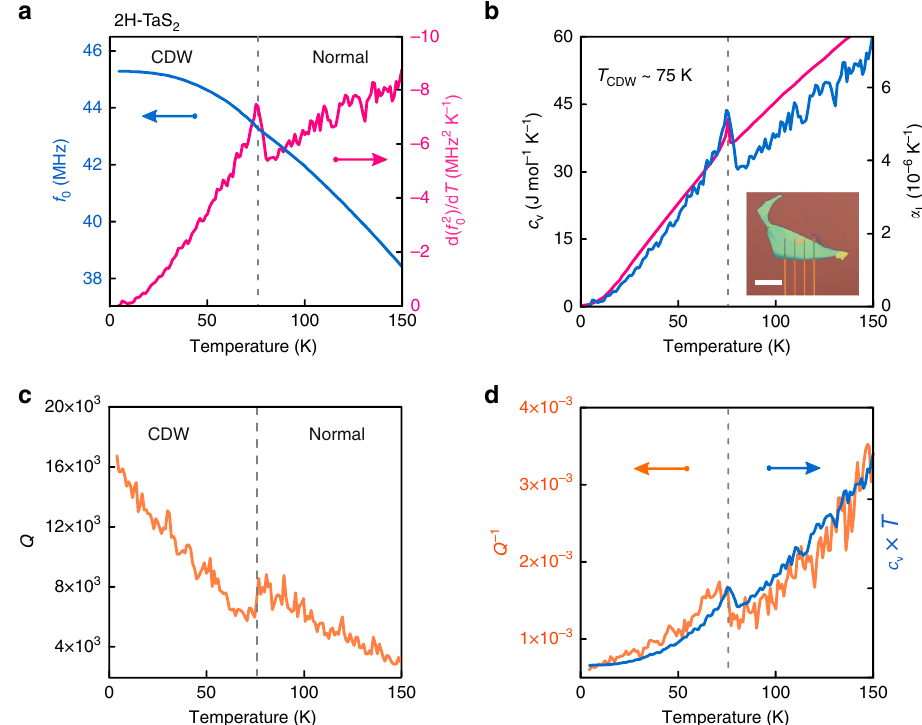
Fig. 4 Mechanical properties of a 2H-TaS 2 resonator with membrane thickness of 31.2 ± 0.6 nm and d = 4 μ m. Dashed vertical line in all 4 panels . a Solid blue line — resonance frequency as a function of temperature. Solid magenta line — indicates the detected T CDW , that is de fi ned by the peak in d ð f 2 0 ð T ÞÞ d T temperature derivative of f 2 . b Solid blue line — experimentally derived c v and thermal expansion coef fi cient as a function of temperature (see 0 Supplementary Note 6). Solid magenta line — speci fi c heat of bulk 2H-TaS 2 as reported in Abdel-Ha fi ez et al. 14 . Inset: optical image of the sample. Scale bar: 20 μ m. c Quality factor Q ( T ) as a function of temperature. d Solid orange line — measured mechanical damping Q − 1 ( T ) as a function of temperature. Solid blue line — curve proportional to the term c v ( T ) T 20,21 (see Supplementary equation (14)), with c v ( T ) taken from the experimental data in ( b